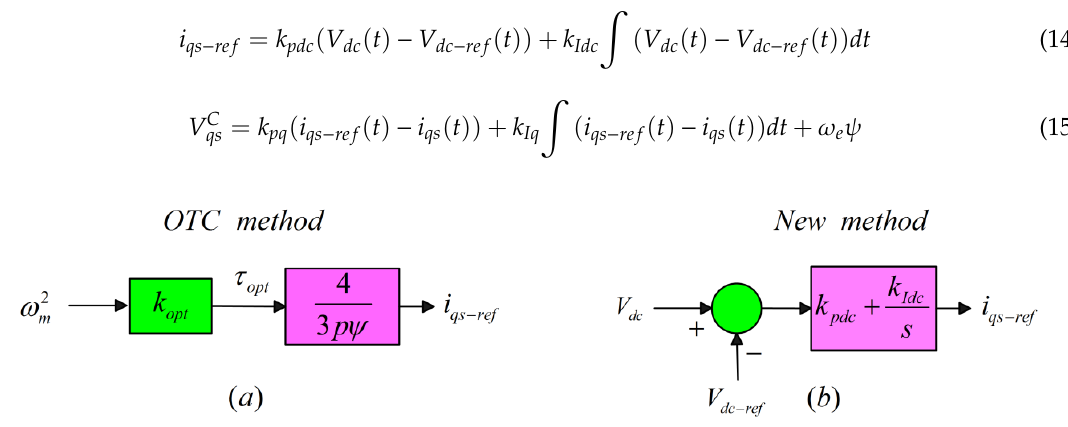
Figure 2. ( a ) Conventional OTC method; and ( b ) utilized method for i qs − ref the calculation to improve LVRT.